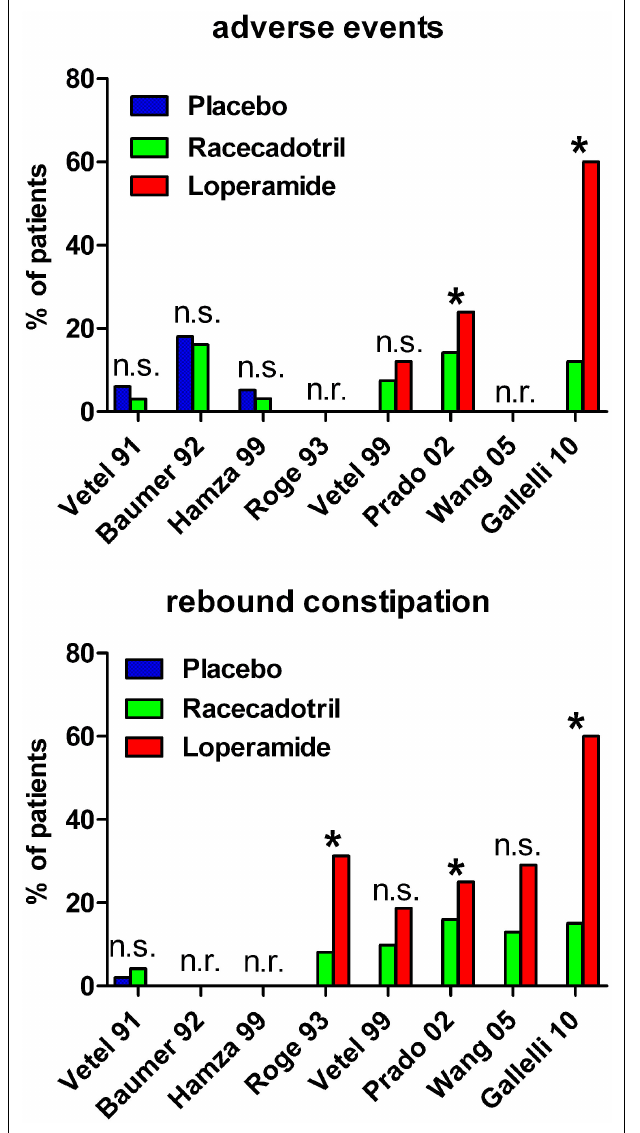
FIGURE 2 | Incidence of adverse events (upper panel) and rebound constipation (lower panel) in controlled studies with racecadotril in the treatment of acute diarrhea in adults. * p < 0.05 vs. comparator; n.s., not significant; n.r., not reported. For study details see main text, for corresponding efficacy results see Table 1 .